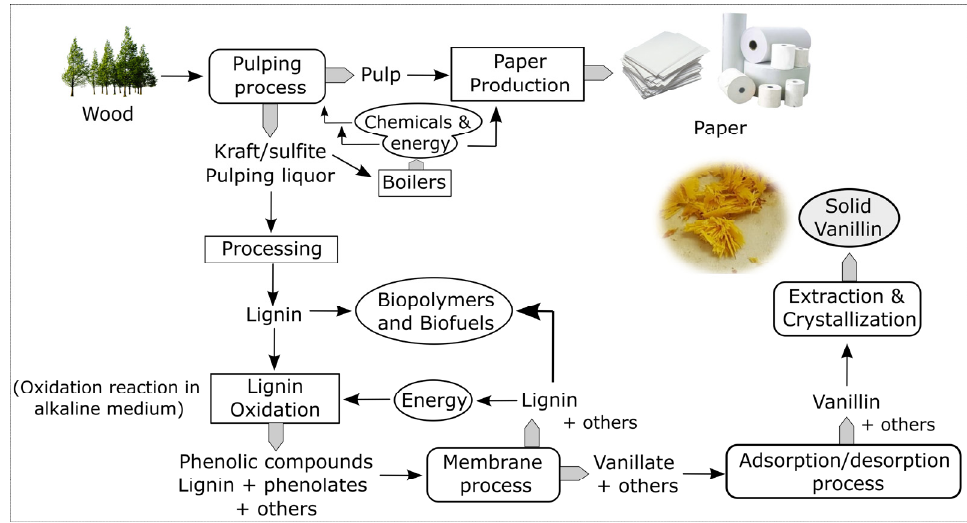
Figure 12. Integrated process to produce value-added phenolics and polymers from lignin in a biorefinery concept. (Modified from [55] Copyright 2009, with permission from Elsevier.)